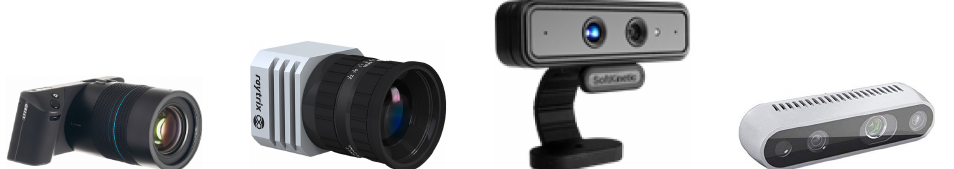
Figure 2. Plenoptic and time-of-flight cameras (left to right: Lytro Illum, Raytrix R42, DepthSense325, RealSense).